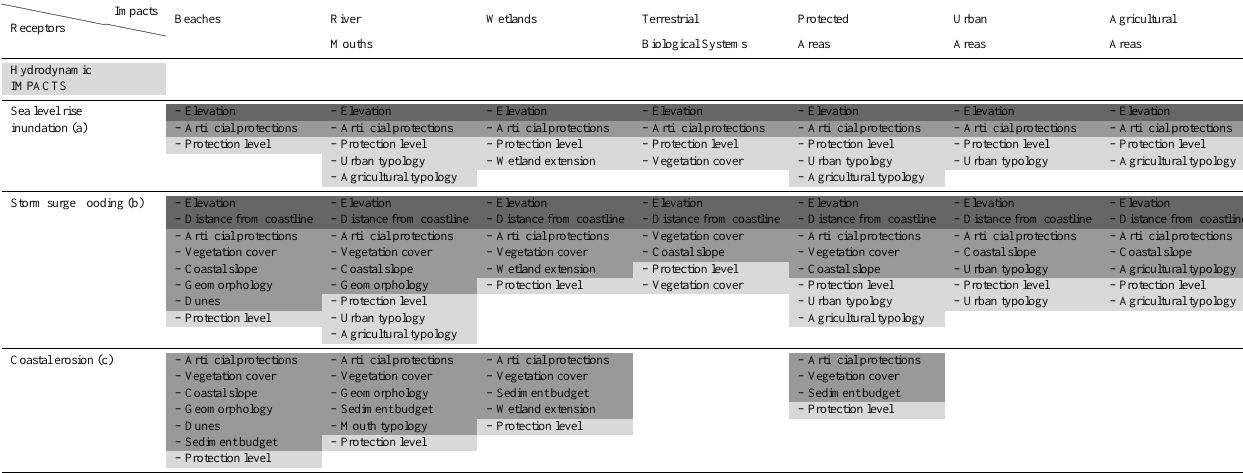
Table 1. Vulnerability matrix applied for the assessment of coastal vulnerability to sea level rise inundation (a), storm surge flooding (b) and coastal erosion (c) in the coastal area of the North Adriatic Sea. Dark grey cells represent pathway factors, grey cells susceptibility factors and light grey cells value factors.